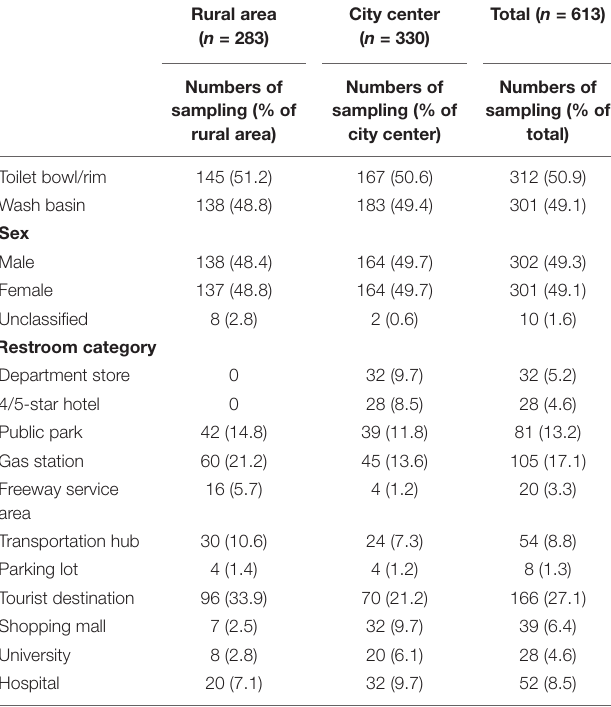
TABLE 1 | Baseline data on sample collection from public restrooms in this study. TABLE 2 | Geographical distribution of resistant E. coli across 613 public restrooms in rural areas and city centers in